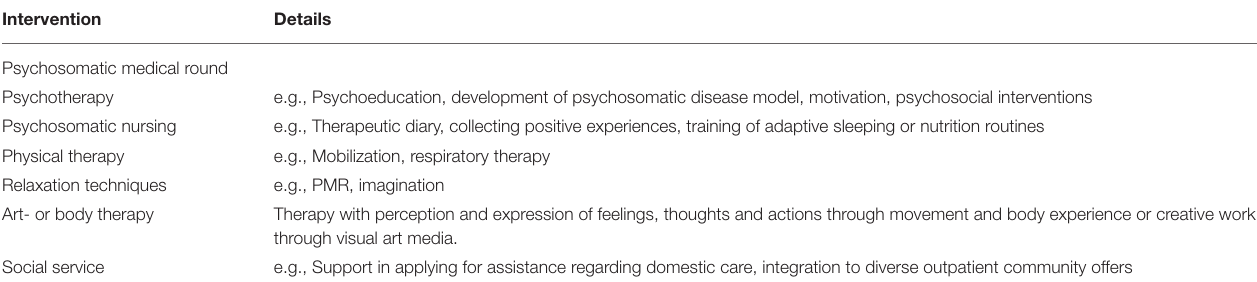
TABLE 1 | NIPA treatment modules.